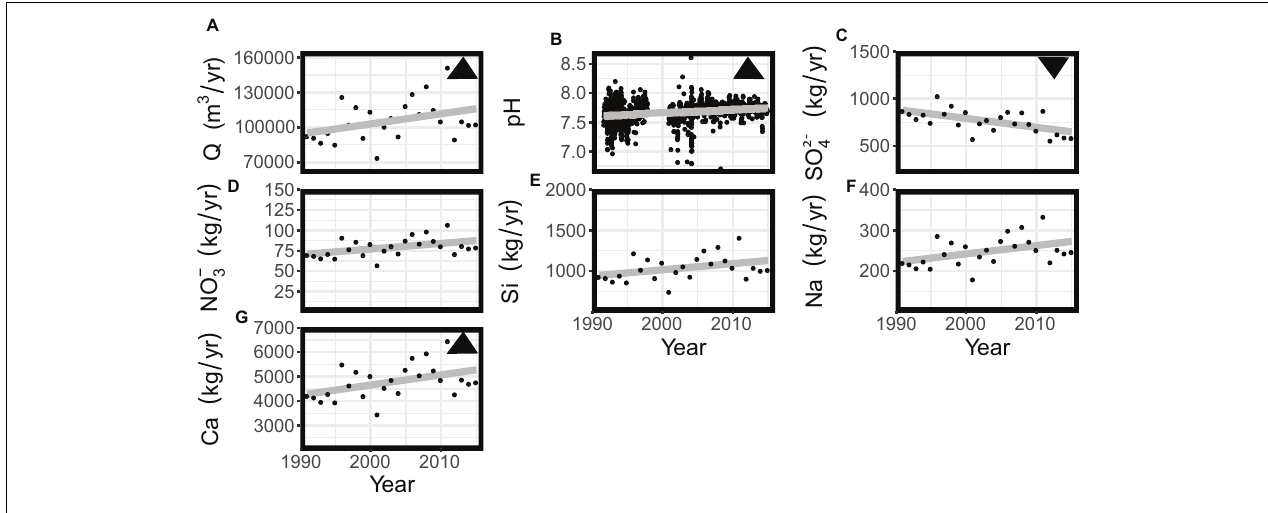
FIGURE 2 | Complete time series for (A) discharge (Q), for the water year (B) pH measurements, and (C–G) annual flux of selected solutes (calendar year). Triangles in the top right corner indicate the directionality of statistically significant trends of linear regression.